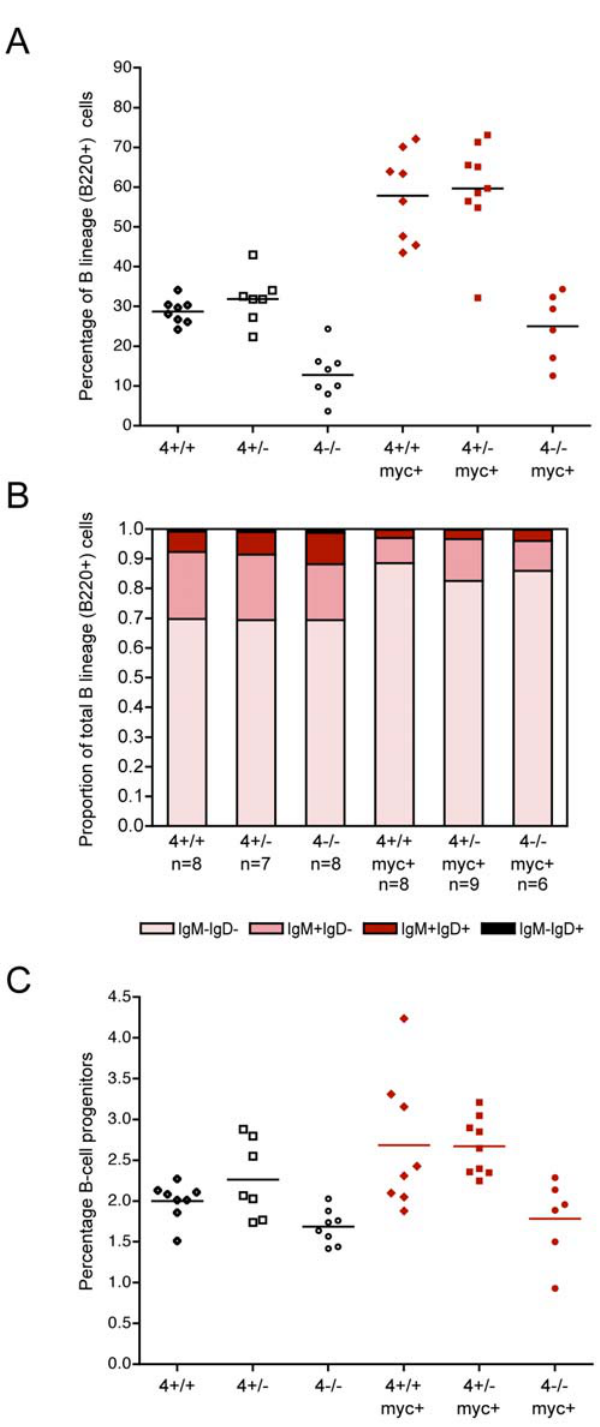
Figure 6. E2f4 deficiency limits expansion of the B lineage in response to Myc. (A) The percentage of B lineage cells (B220 + ) within the bone marrow of normal and pretumorous E2F4 cohort mice with the indicated genotypes. (B) Proportions of bone marrow B lineage cell populations (B220 + ), from early to more mature stages, across the E2F4 cohort: surface immunoglobulin negative cells, IgM positive IgD negative B cells, IgM positive IgD positive B cells, and IgM negative IgD positive B cells. (C) The proportion of immature B lineage cells (B220 + CD43 + ) in the bone marrow of non-transgenic and pretumorous E2F4 mice of the indicated